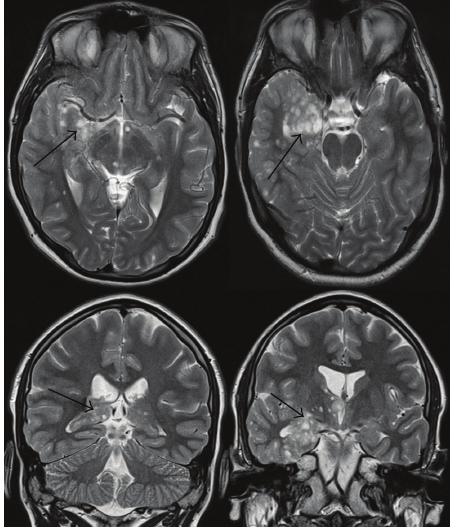
Figure 2: Axial and coronal T2 images demonstrating the right temporal lobe lesion (arrows) with bilateral numerous nodular